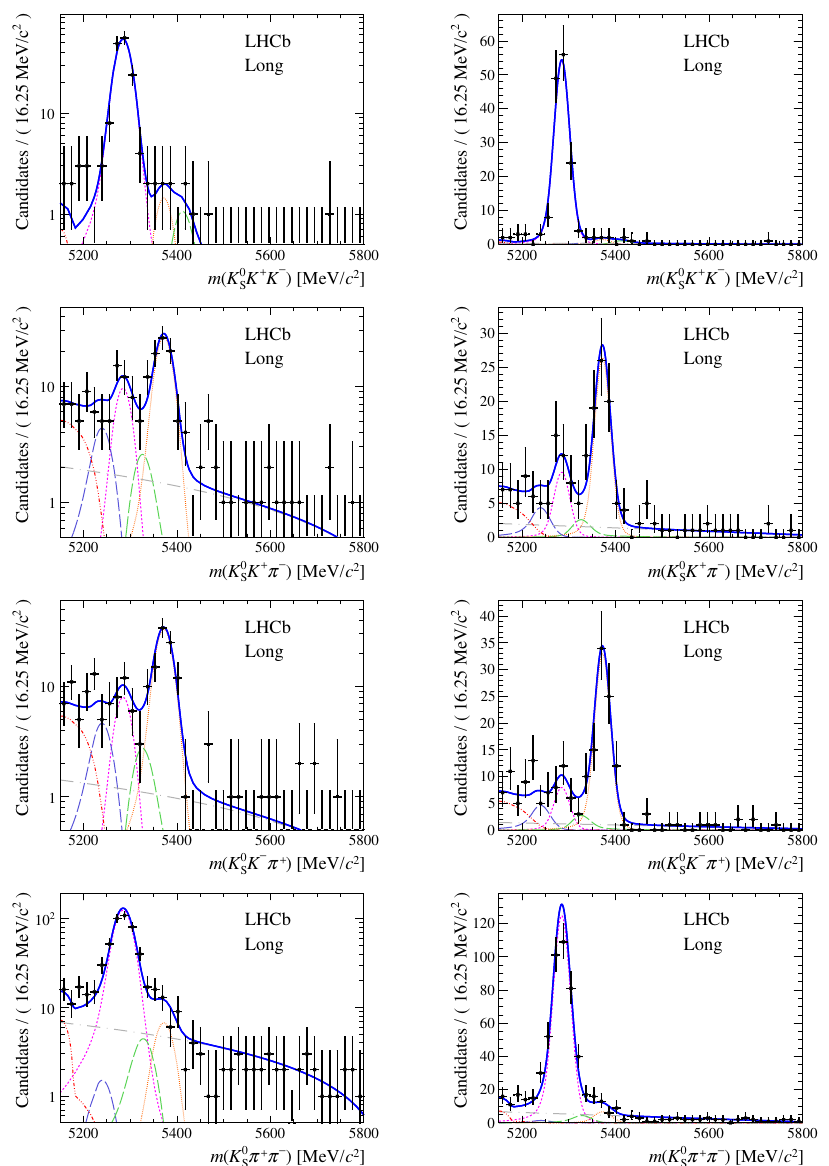
Figure 12 . Results of the simultaneous (cid:12)t to data (long, 2011) with the BDT optimisation corre- sponding to the suppressed modes. The modes K 0 shown from top to bottom. The left-hand side plots show the results with a logarithmic scale and the right-hand side with a linear scale. Legend is similar to that of plots shown in (cid:12)gure 1.